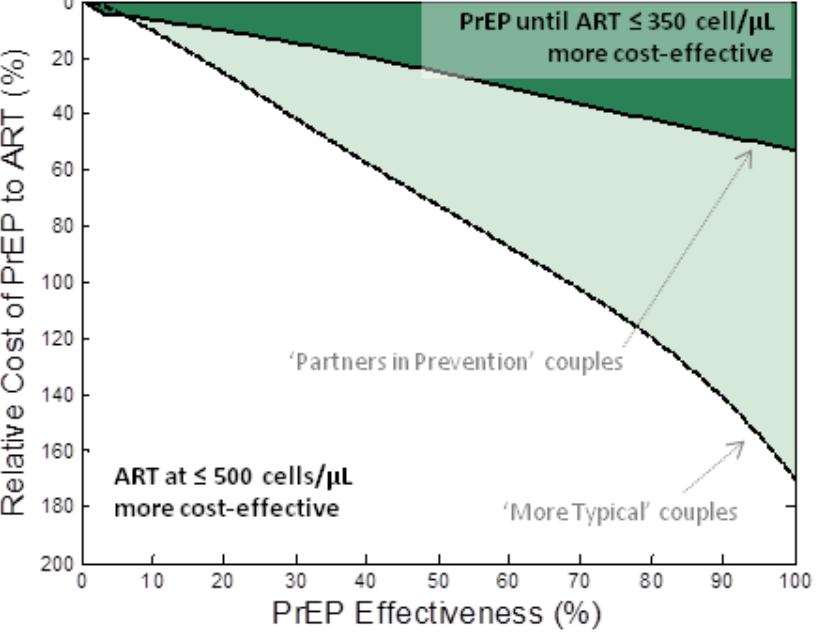
Figure 2. Comparison of PrEP versus earlier ART initiation for keeping couples ‘‘alive and HIV free at 50.’’ The relative cost of PrEP to ART (vertical axis) and the effectiveness of PrEP (horizontal axis) are varied and the shaded region indicates the conditions where a PrEP intervention (PrEP used up to the moment that their infected partner starts treatment (at CD4 , 350 cells/ m l)) is at least as cost-effective as earlier initiation of ART (at CD4 , 500 cells/ m l) at allowing couples to be ‘‘alive and HIV-1 free at 50.’’ The dark shaded region corresponds to the ‘‘partners in prevention’’ assumptions about couples’ behaviour and the lighter shaded region corresponds to ‘‘more typical couples’’ behaviour assumptions. Alternative analyses are presented where different assumptions about ART initiation and couples’ behaviour are made (Figure S3) and where the comparison is based on savings of QALYs (Figure S4).